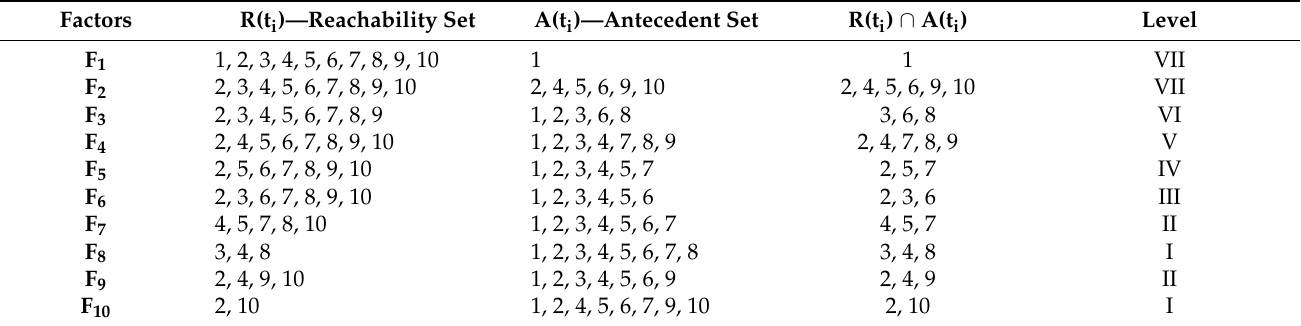
Table 11. Level partition of the